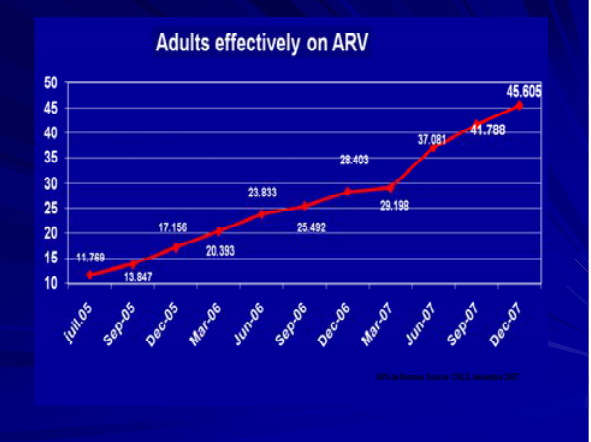
Figure 3: Access to ARV in adults in Cameroon (July 2005 - December